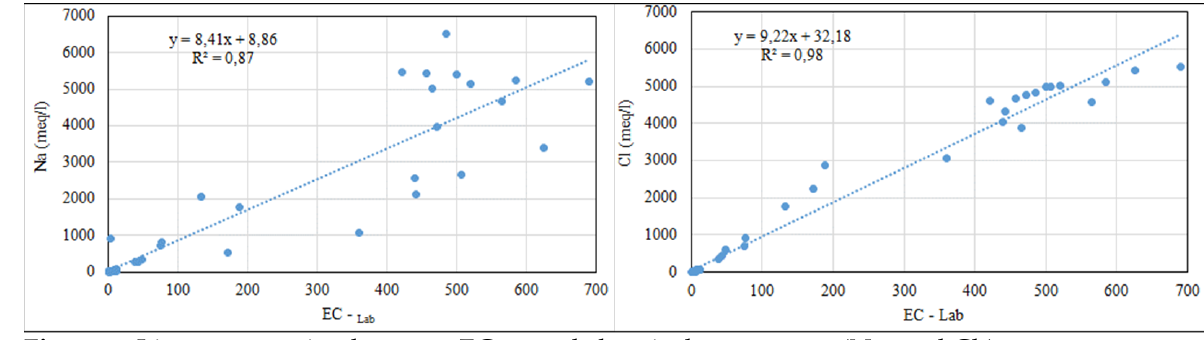
Figure 6. Linear regression between EC -Lab and chemical parameters (Na + and Cl − ).